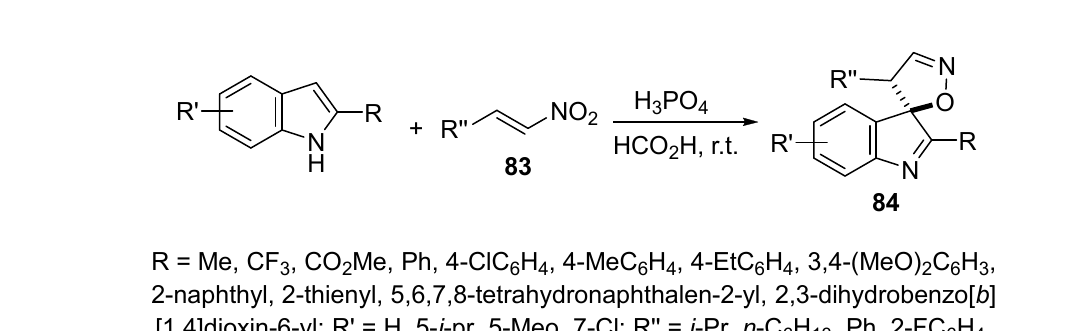
[1,4]dioxin-6-yl; R' = H, 5- i -pr, 5-Meo, 7-Cl; R'' = i -Pr, n -C Spiro[indole-3,5 ′ -isoxazoles] 84 were obtained through the reaction of 2-arylindoles H , 4-ClC 4-FC 6 4